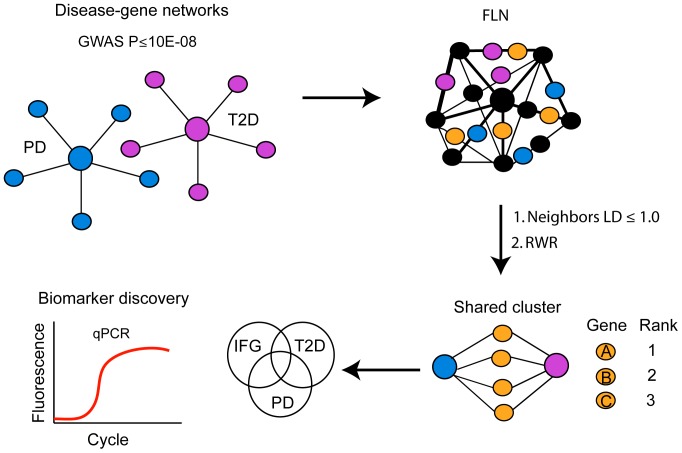
Integrative network approach.Genes with a genome-wide significance of P<10−08 or less associated with Parkinson's disease (displayed in blue) and type 2 diabetes (displayed in purple) were included in this study and specified as training genes. A random walk algorithm within the functional linkage network (displayed in gray) was performed to identify candidates genes with a linkage distance (LD) to the training genes of less than or equal to 1 within the FLN. Candidate genes (displayed in orange) were ranked and scored according to their closeness with training genes. Data from microarrays studies in blood of Parkinson's disease, pre-diabetes and Type 2 diabetes patients was analyzed to identify genes dysregulated in both diseases. Quantitative PCR assays were used to validate a potential biomarker in blood of Parkinson's disease patients. Networks were visualized using Cytoscape 2.8.3. PD  =  Parkinson's disease, IFG  =  pre-diabetes and T2D  =  type 2 diabetes.